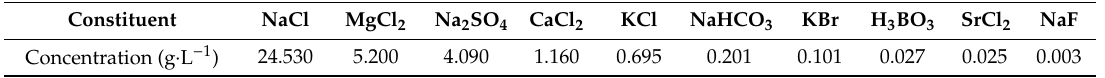
Table 3. Chemical composition of artificial